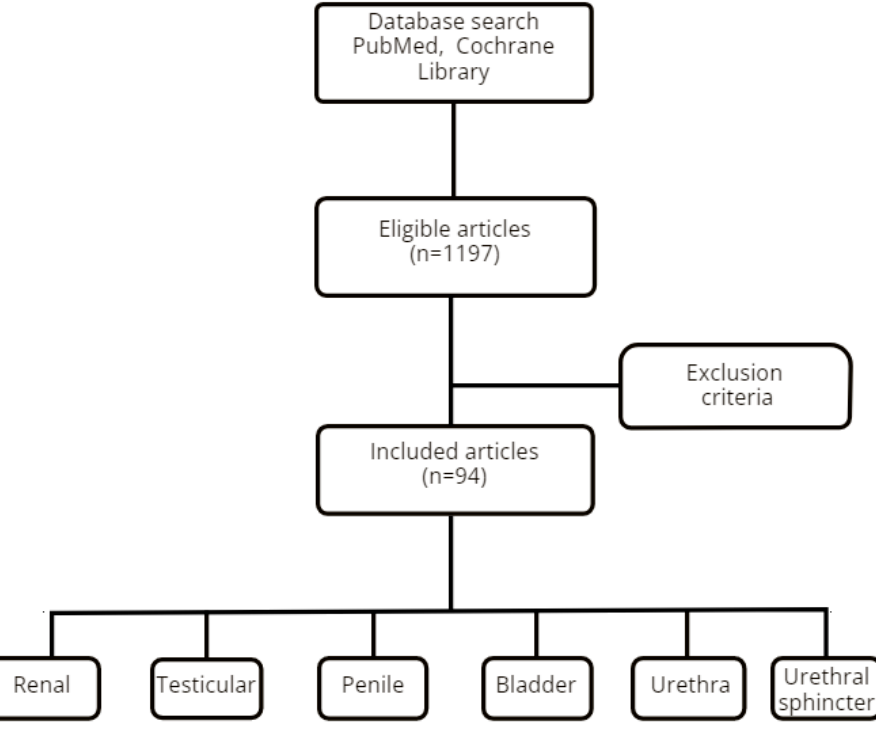
Figure 1. STARD diagram of the inclusion and exclusion criteria